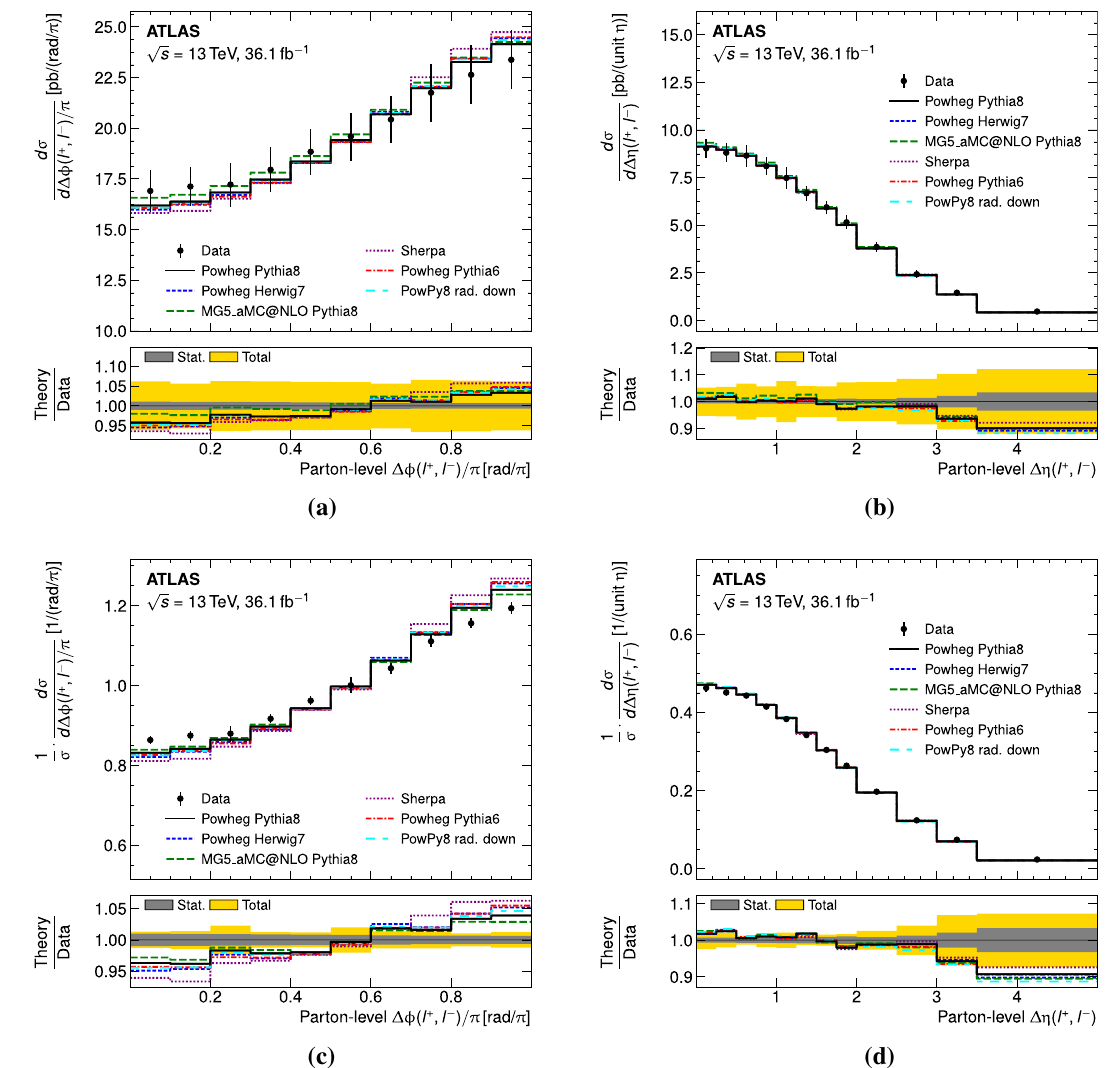
Fig. 6 The parton-level differential cross-sections compared to predictions from Powheg , MadGraph5 _aMC@NLO and Sherpa : (top) , absolute a (cid:3)φ and b (cid:3)η and (bottom) , normalised c (cid:3)φ and d (cid:3)η , using the inclusive